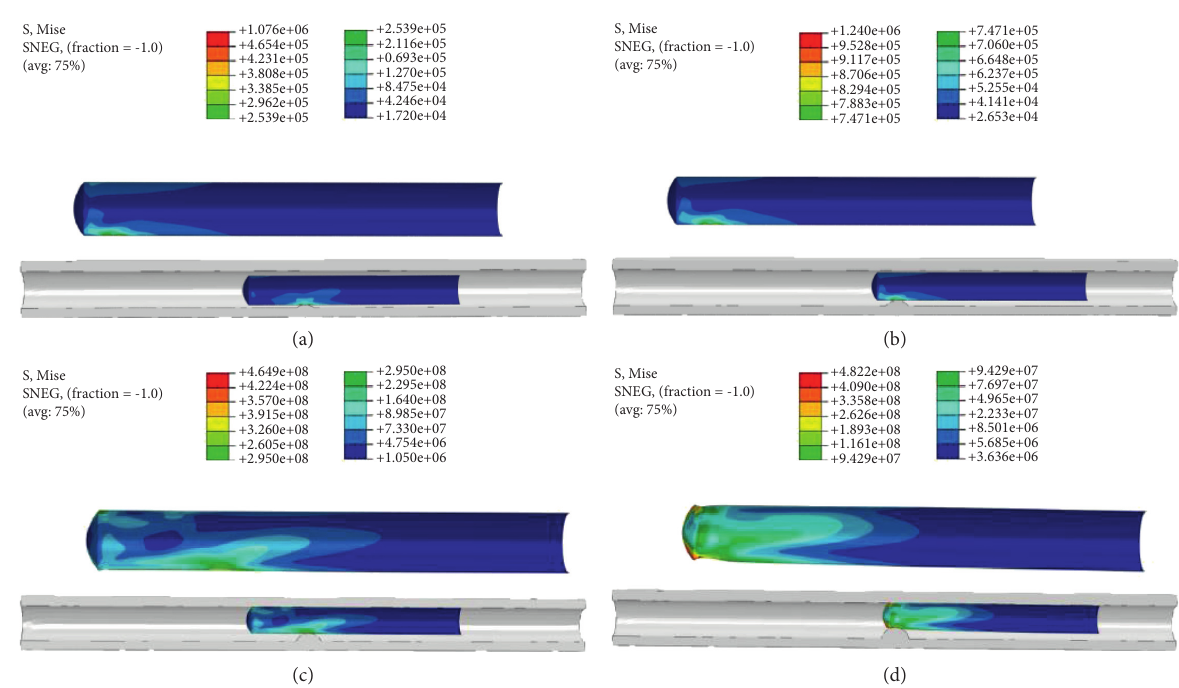
Figure 5: Contact stress distribution in borehole at different step